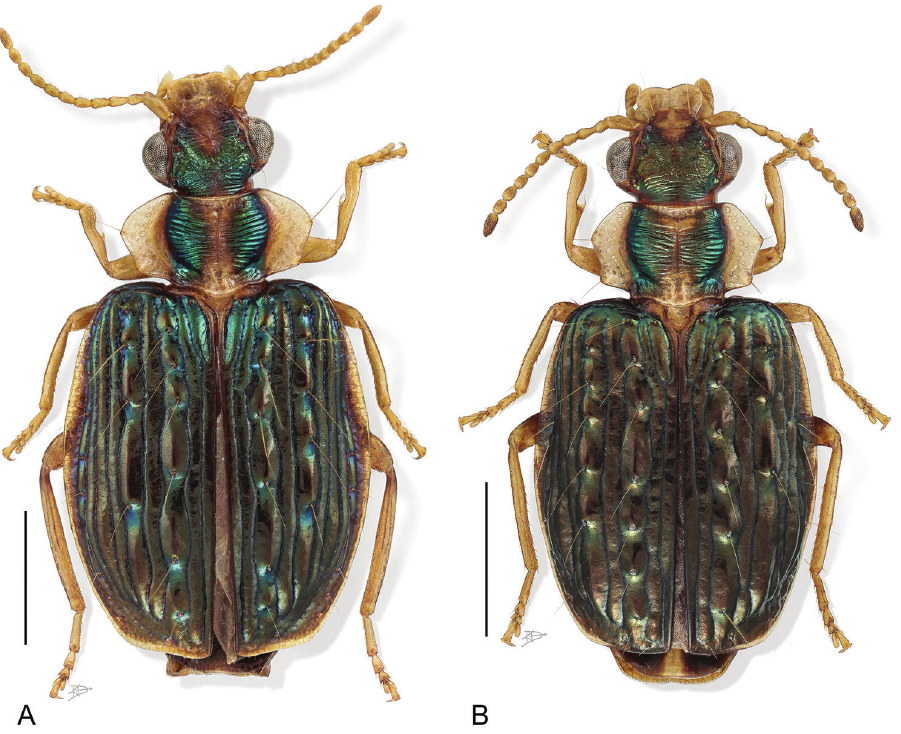
Figure 1. Digital Photo-illustration. Habitus, dorsal aspect. A Hyboptera angulicollis Chaudoir, female, ADP052729 B Hyboptera biolat Erwin & Henry, sp. n., female,